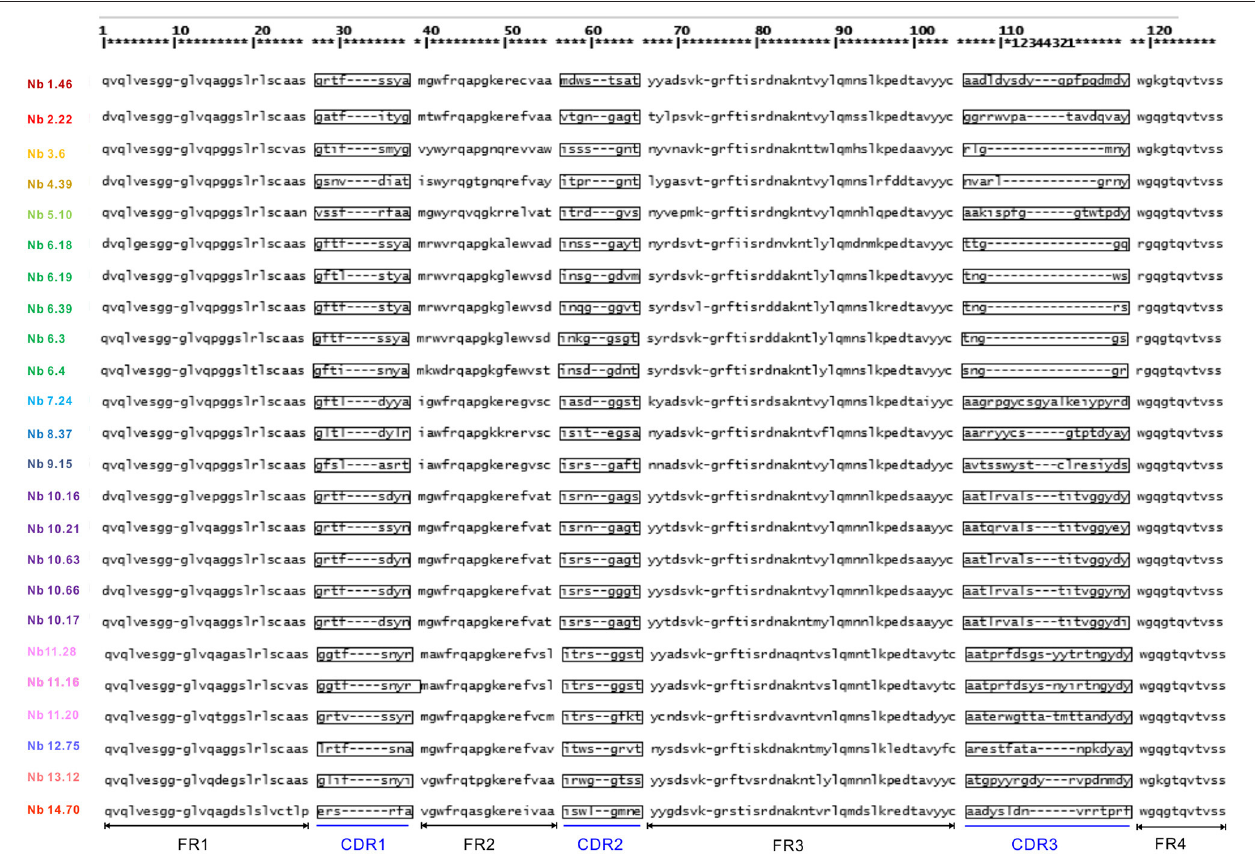
FIGURE 2 | Amino acid sequence of Clec4F nanobodies (numbering according to IMGT). Deduced amino-acid sequences of different nanobodies, consisting of complementarities determining regions (CDR) sequences alternated with structural framework region (FR) sequences.